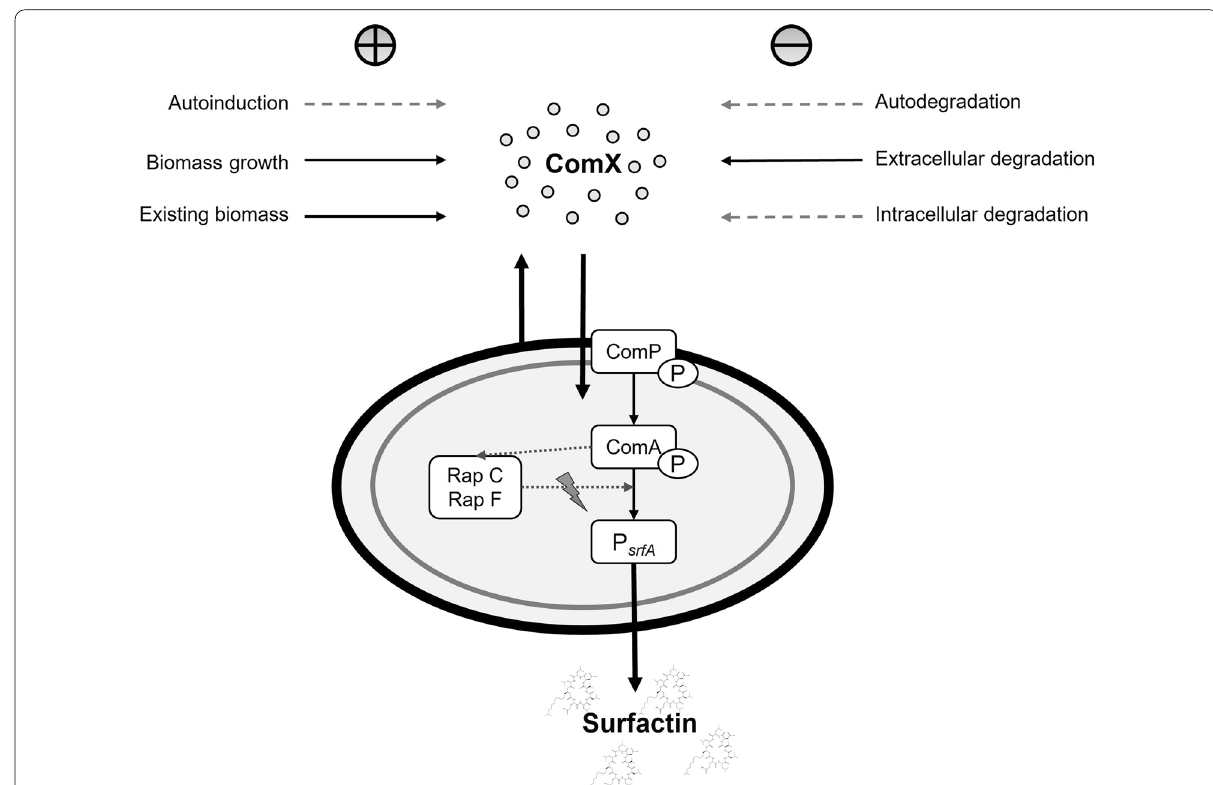
Fig. 1 Schematic illustration of potential influencing factors on ComX concentration and surfactin production . The terms included in the here presented model for ComX time course are marked with a solid line